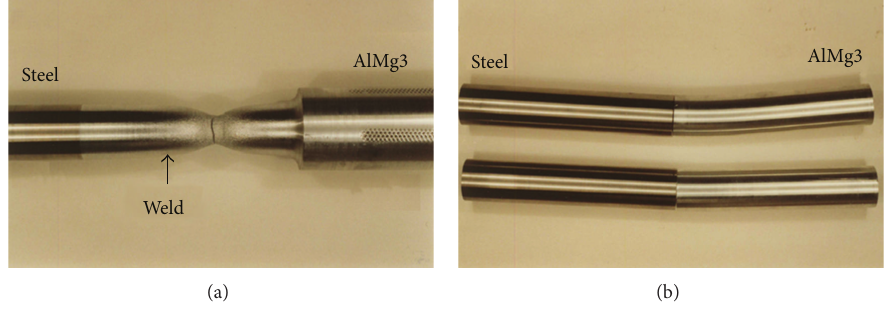
Figure 6: View of friction welded joints of AlMg3 aluminium alloy-X10CrNiTi189 austenitic steel, after the static tensile test (a) and the technological bending test with a bending mandrel with diameter of 20 mm and 100 mm (b).